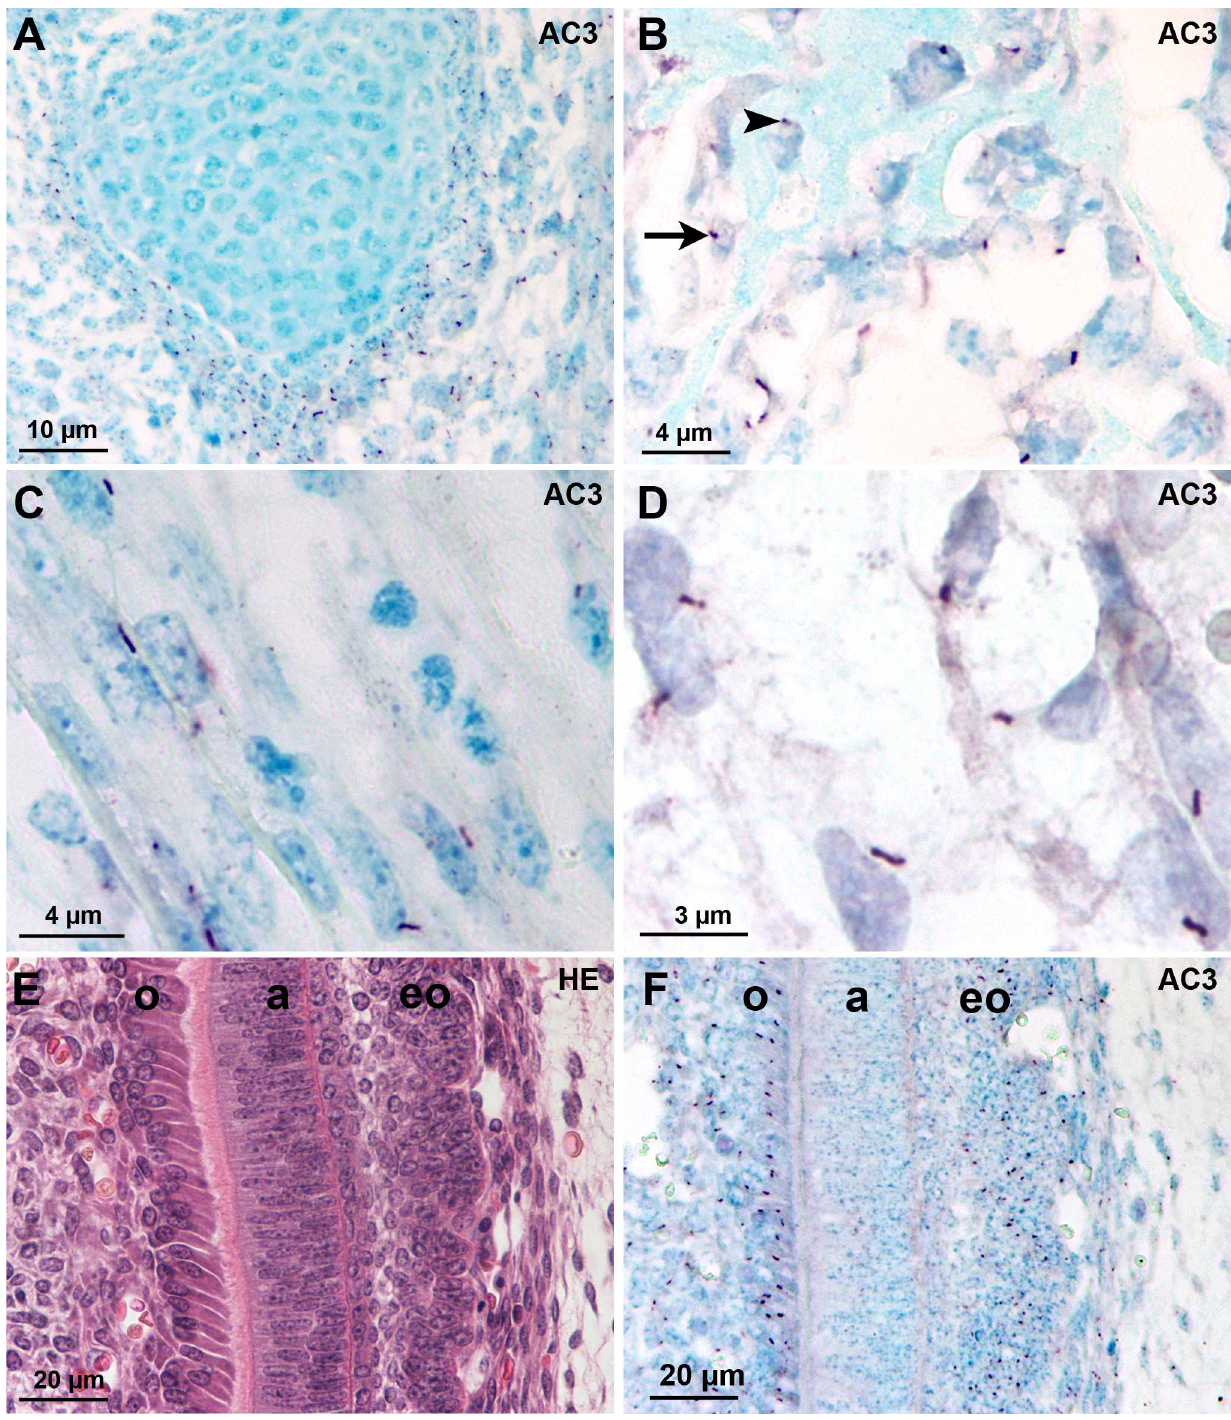
Fig 2. AC3-positive cilia in human and mouse tissues of mesenchymal origin during development. (A-D) Tissue sections from a GW12 humanfetus. (A) Meckel’scartilage: short AC3-positive cilia in perichondral cells and chondroblasts. (B) Bone trabecula: AC3-positive cilia are present in osteoblasts(arrow) and osteocytes (arrow head). (C) Myotubes. (D) Mesenchymal cells. (E, F) Adjacent sections of a mouse tooth at the bell stage. (E) Hematoxylin-eosinstaining.(F) AC3 immunohistochemistry shows positive cilia on odontoblasts (o) and peripheral cells of the enamelorgan (eo) but not in ameloblasts (a). Abbreviations: AC3: adenylatecyclase type III; HE: Hematoxylin-eosin.